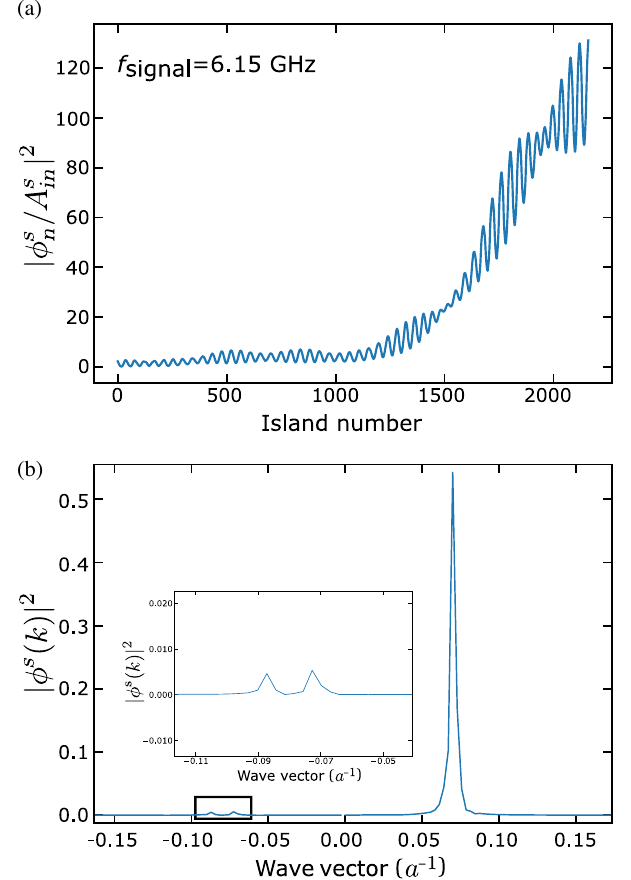
j 2 for pump frequency equals to 6.901 GHz and FIG. 8. (a) j ϕ s n − 70 dBm incident power. Signal frequency is 6.15 GHz. (b) Fou- rier transform j ϕ s ð k Þj 2 of the signal shown in (a).